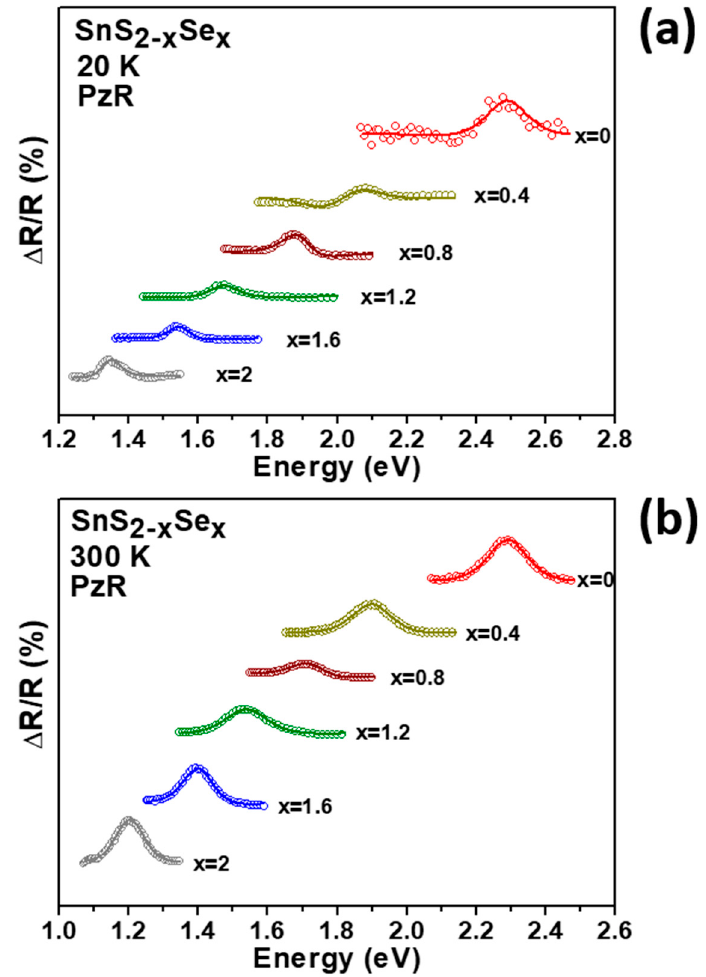
Figure 3. The experimental PzR spectra (dashed curves) of SnS 2-x Se x layered crystals at ( a ) 20 K and ( b ) 300 K. The solid curves are least-squares fits to Equation (1) which yields the excitonic transi- tion energies.